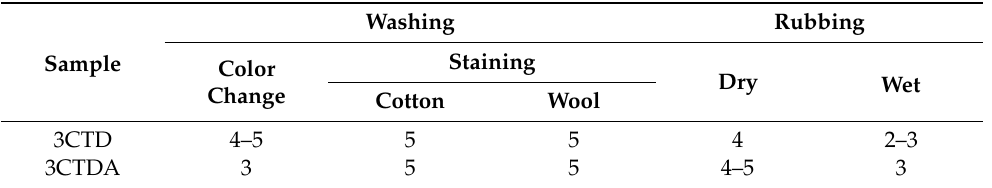
Table 16. Results of the washing and rubbing fastness tests of the samples dyed with calendula with or without rinsing.